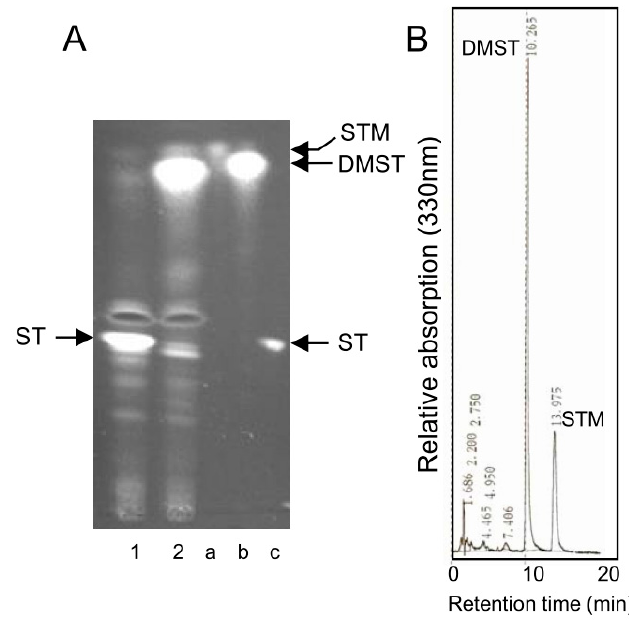
Figure 6. The accumulation of STM together with DMST in A. nidulans stcP disruptant. stcP gene is a homolog of A. parasiticus dmtA. ( A ) After A. nidulans FGSC26 (wild strain) (1) and TAHK64.42 stcP disruptant (2) were cultured in oat flakes medium for 5 days, and the resulting media were extracted with a solution containing acetone:chloroform (1:1, v / v ). The resulting extracts were analyzed by TLC using a solution of benzene:ethyl acetate (7:3, v / v ). The TLC plate was then sprayed with 10% aluminum chloride in ethanol followed by heating at 80 ◦ C for 5 min. Authentic standards of STM (a), DMST (b), and ST (c) were also analyzed. Similar results were reported by Kelkar et al. (1996). ( B ) The part corresponding to the spot of STM on the TLC plate (A) was extracted and then the extract was analyzed by HPLC.